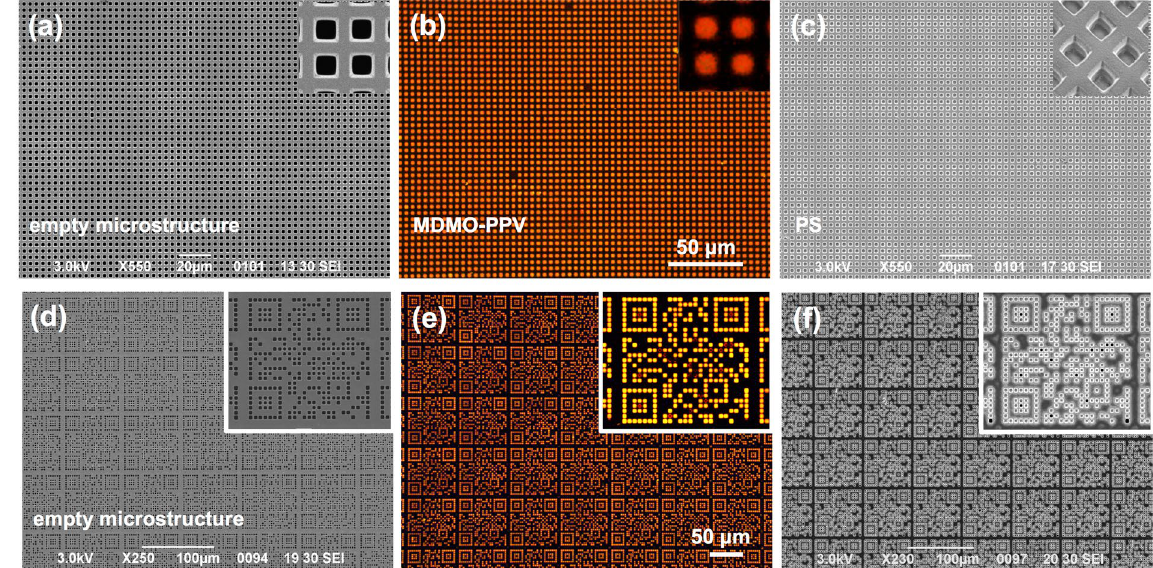
Figure 4. Preparation of Both Regular and Non-Regular ( μ QR codes) Micrometric Suspended MDMO- PPV and PS Membrane Lattices. ( a – c ) Top-view SEM ( a , c ) and 50 × optical ( b ) images of a silicon template featuring 2D arrays of open-ended micropipes featuring pitch of 4 μ m before polymer drop-casting ( a ) and after formation of suspended membrane lattices in MDMO-PPV ( b ) and PS ( c ), with higher magnification insets. ( d – f ) Top-view SEM ( d , f ) and 20 × optical ( e ) images of a silicon microstructured template consisting of 2D repetitions of square lattices featuring a QR-code-like pattern of 2- μ m-sized open-ended micropipes